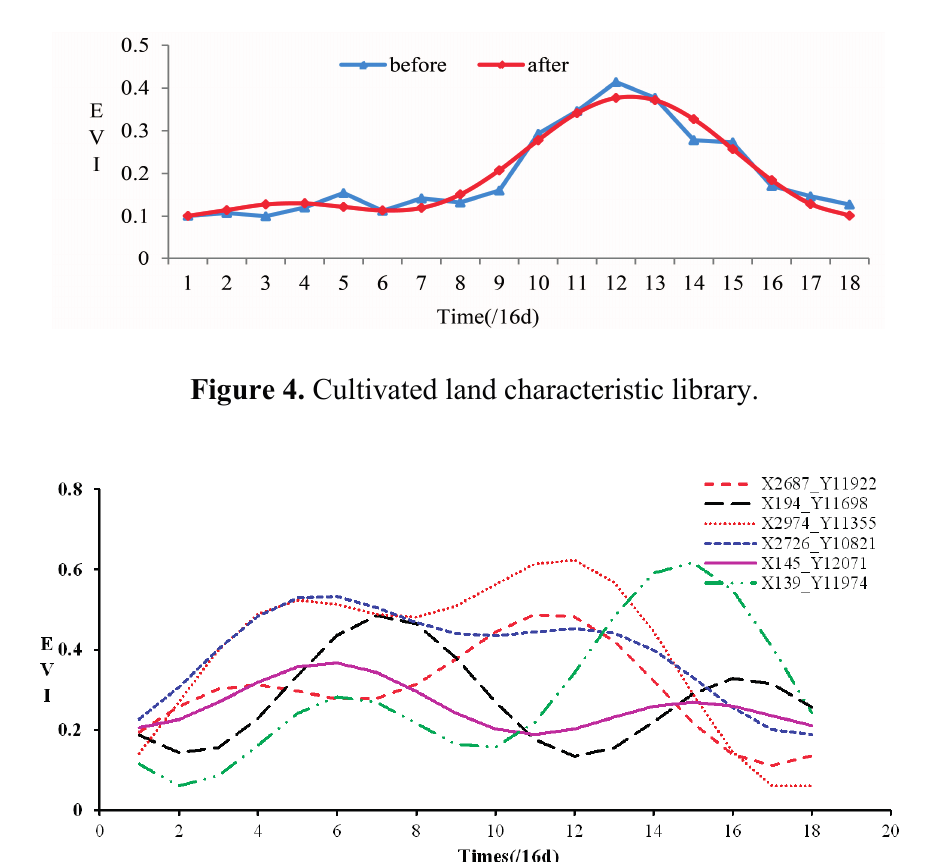
Figure 3. EVI time-series curves before and after a harmonic analysis.